Question: What does this figure show? Answer in one sentence.
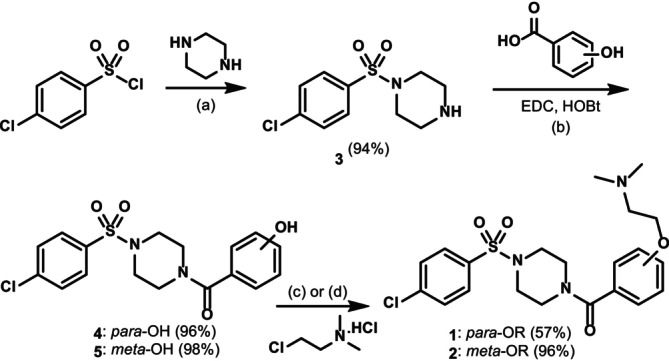
Answer: Synthesis of lead candidates 1 and 2 . Reagents and conditions: (a) Et3N, DCM, 0°C—rt, 14 h, 94%; (b) DMF, rt, 18–35 h, 96%–98%; (c) NaH (60% in mineral oil), DMF, Ar atm., 70°C, 24 h, 57% (for 1 ); (d) tBuONa, DMF, 60°C, 48 h, 96% (for 2 ).